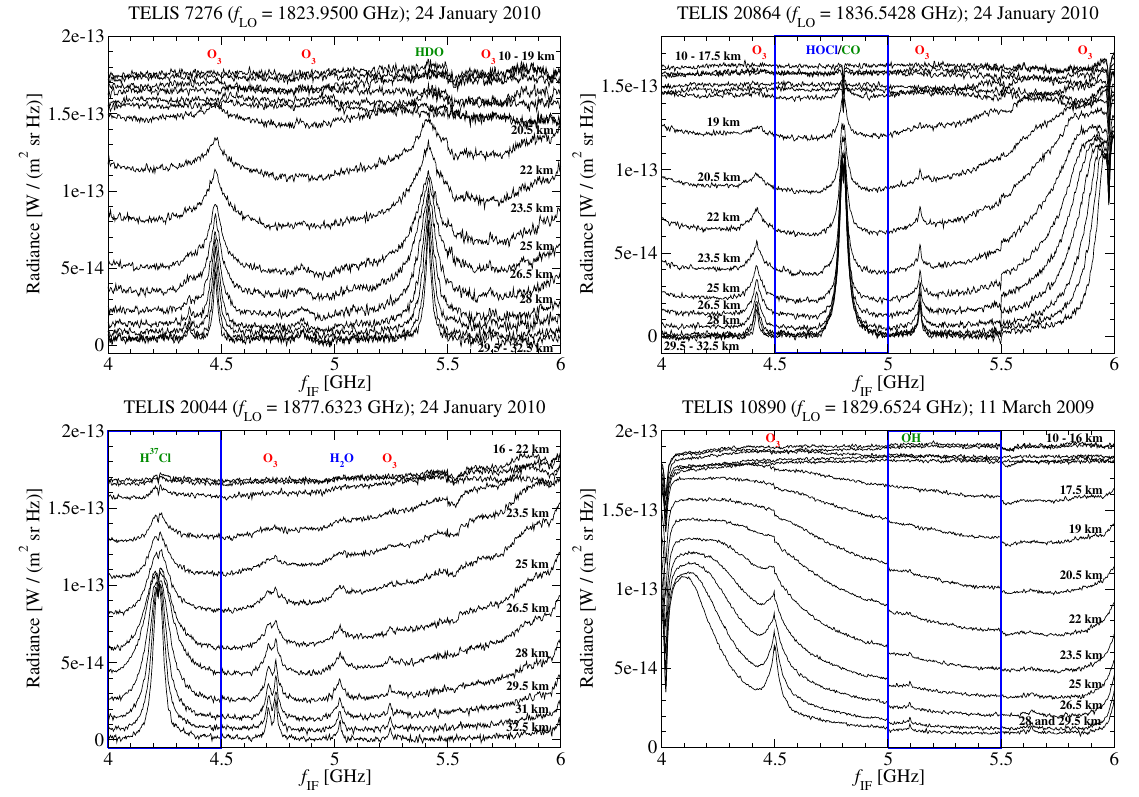
Figure 1. Typical sequences of limb spectra corresponding to four microwindows (top left: semi-heavy water (HDO), top right: carbon monoxide (CO); bottom left: hydrogen chloride (HCl), bottom right: hydroxyl radical (OH)) measured by the TErahertz and submillimeter LImb Sounder (TELIS) 1.8-THz channel during the 2009 and 2010 flights. These limb sequences, covering tangent heights from 10 or 16km up to 32.5km in steps of 1.5km, are illustrated as a function of intermediate frequency f IF . Please note that 7276, 20864, 20044, and 10890 are the associated measurement